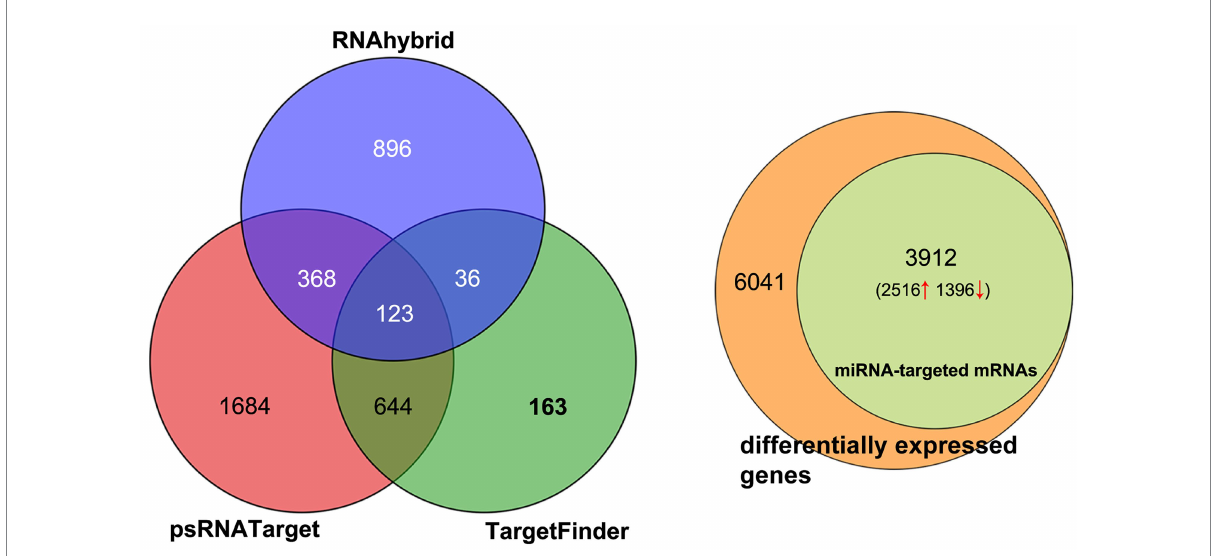
FIGURE 3 Distribution of miRNA-targeted genes. (A) Target genes predicted by RNAhybrid, psRNATarget, and Targetfinder. (B) miRNA-targeted mRNAs accounting for total differentially expressed